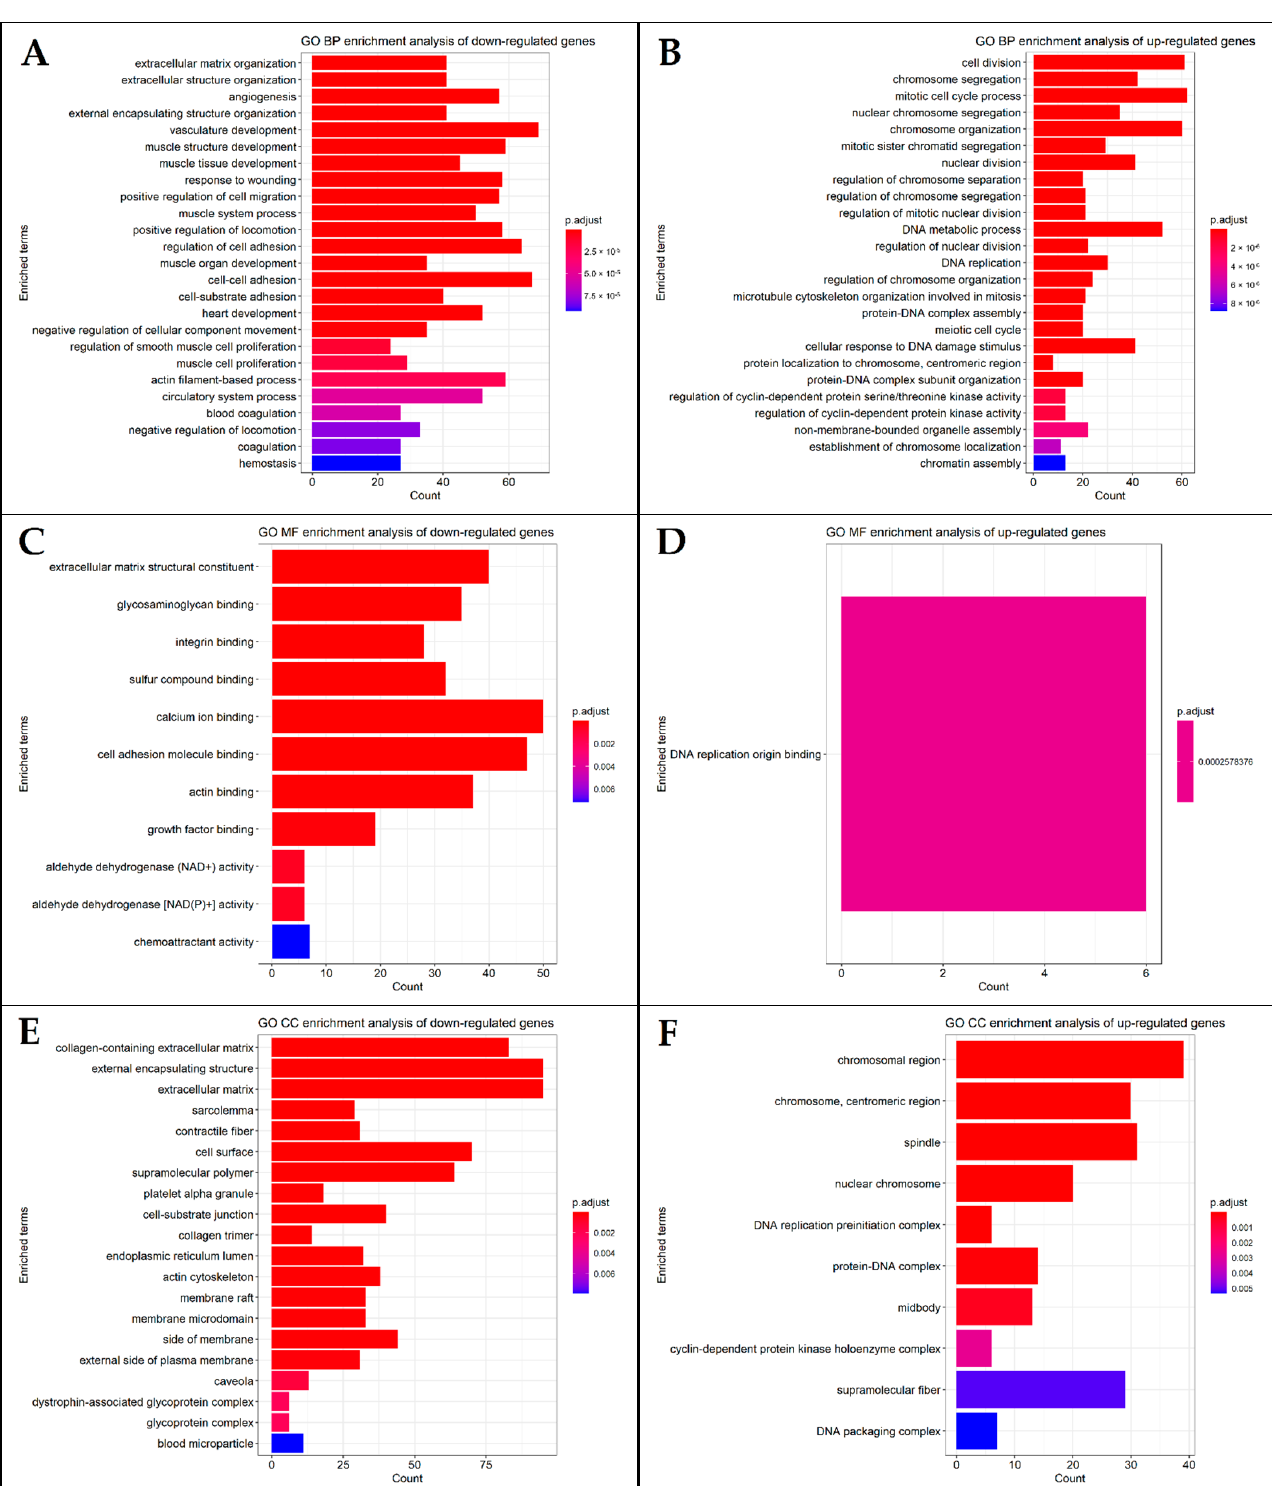
Figure 4. Top 25 significant Gene Ontology (GO) enrichment analysis terms of ( A , B ) biological processes (BP) of down- and upregulated DEGs; ( C , D ) molecular functions (MF) of down- and upregulated DEGs; ( E , F ) cellular components (CC) of down- and upregulated